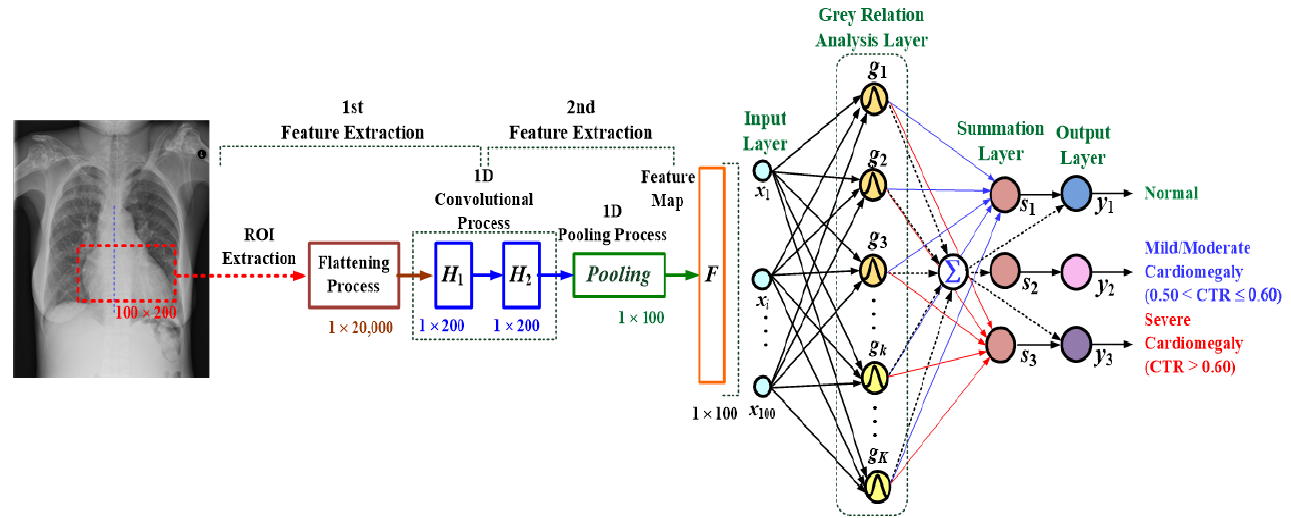
Figure 3. Architecture of the proposed multilayer 1D convolutional neural network-based classifier for cardiomegaly level screening.